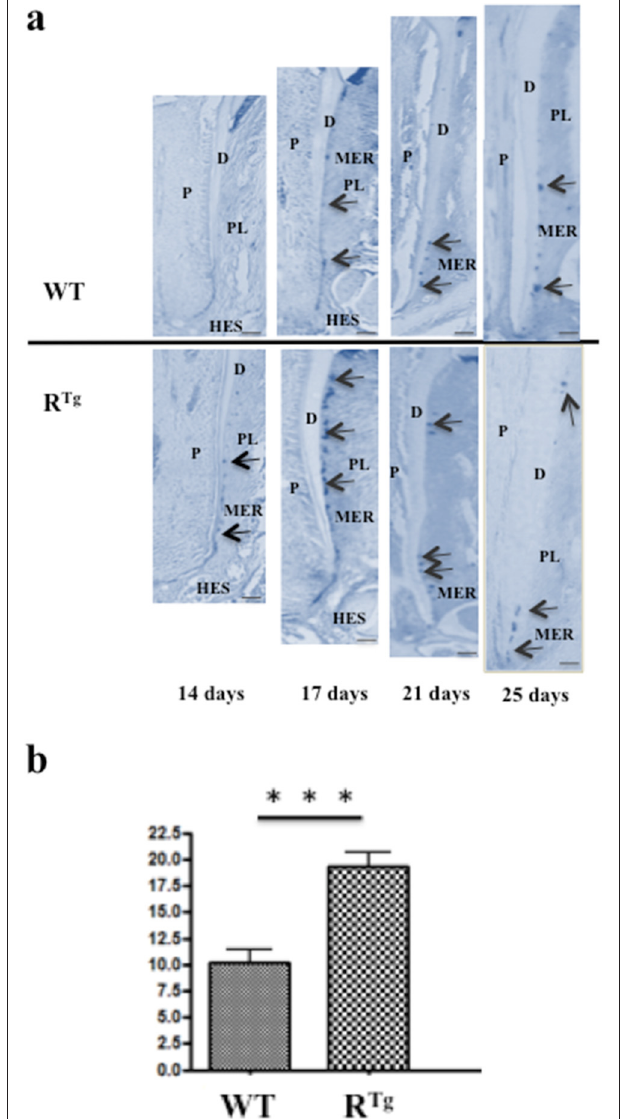
FIGURE 8 | Longitudinal analyses from days 14 to 25 of the number of Malassez epithelial rests (MER) based on Keratin 14 immunohistochemistry comparatively in R Tg and WT mice. Keratin 14 positive MER were numbered in equivalent areas of the mandible first molar roots of WT and R Tg mice at 14, 17, 21, and 25 days-old (arrows in a ). Obtained values were combined in a single statistic analysis in order to represent the median global variation of the MER number during the whole root elongation (b) showing a significant (*** p < 0.001) increase in the R Tg mice. P, pulp; D, dentin; C, cementum; PL, periodontal ligament; HES, Hertwig epithelial root sheath. Scale bars correspond to 10 µ m. The gingival and MER hyperplasia observed in the R Tg mouse may also be autonomous or indicative of a local inflammatory process exclusively related to RANK overexpression in epithelial cells ( Figure 6 ). The hypothesis is that RANK overexpression in epithelial cells stimulate the proliferation and block the final differentiation of the cells as already describe for epithelial